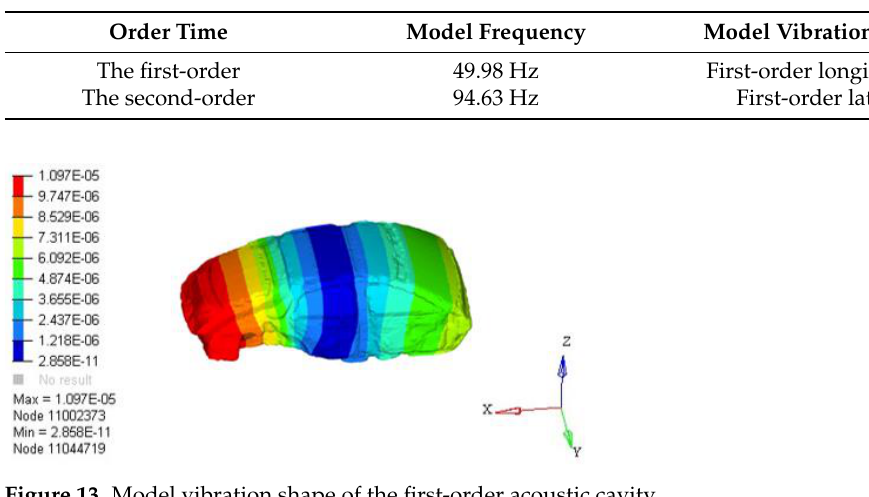
Figure 13. Model vibration shape of the first-order acoustic cavity.